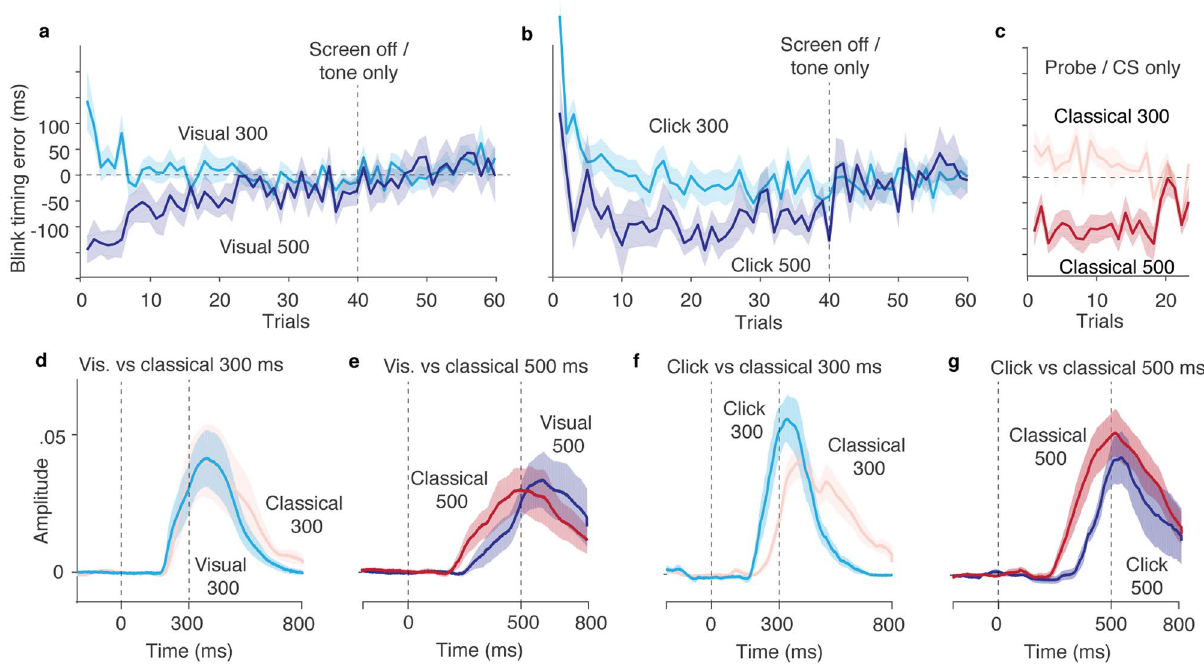
Figure 3. Timing of blink responses. ( a , b ) Learning of voluntary response timing. Average (mean ± SEM) difference between the target time and the peak of the blink response for the delayed visual feedback paradigm and the click paradigm. ( c ) Response timing (mean ± SEM) on randomly interspersed probe trials during training and on the 10 CS alone trials after training in the standard eyeblink. ( d – g ) Comparison of blink responses on CS alone trials after training in a voluntary paradigm (dark and light blue) and a standard eyeblink conditioning paradigm (red and